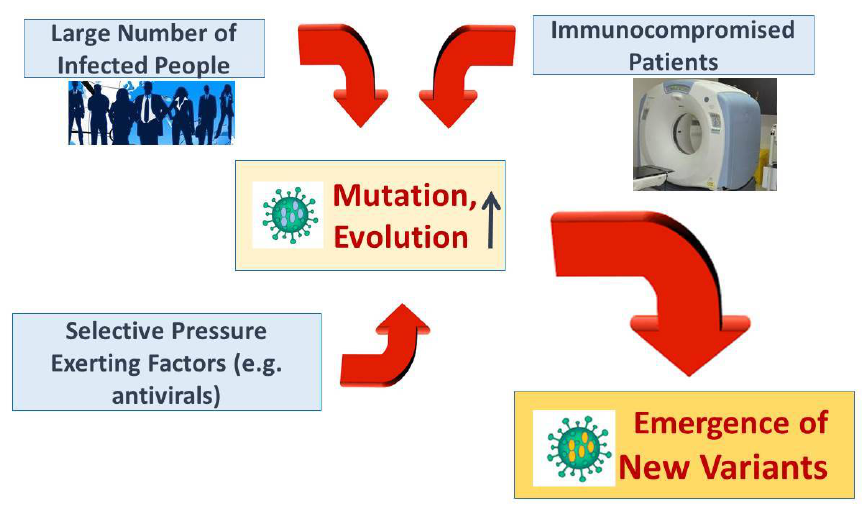
Figure 2. Factors such as the large number of infected people, the existence of immunocompromised patients (such as cancer patients), and treatment methods such as antivirals that exert selective pressure on SARS-CoV-2, increase the likelihood of viral evolution through adaptive mutations and hence increase the chance of emerging new variants.